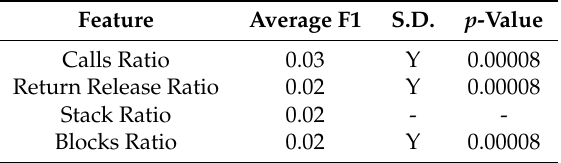
Table 17. Zeus Previous Numeric Feature Encoding